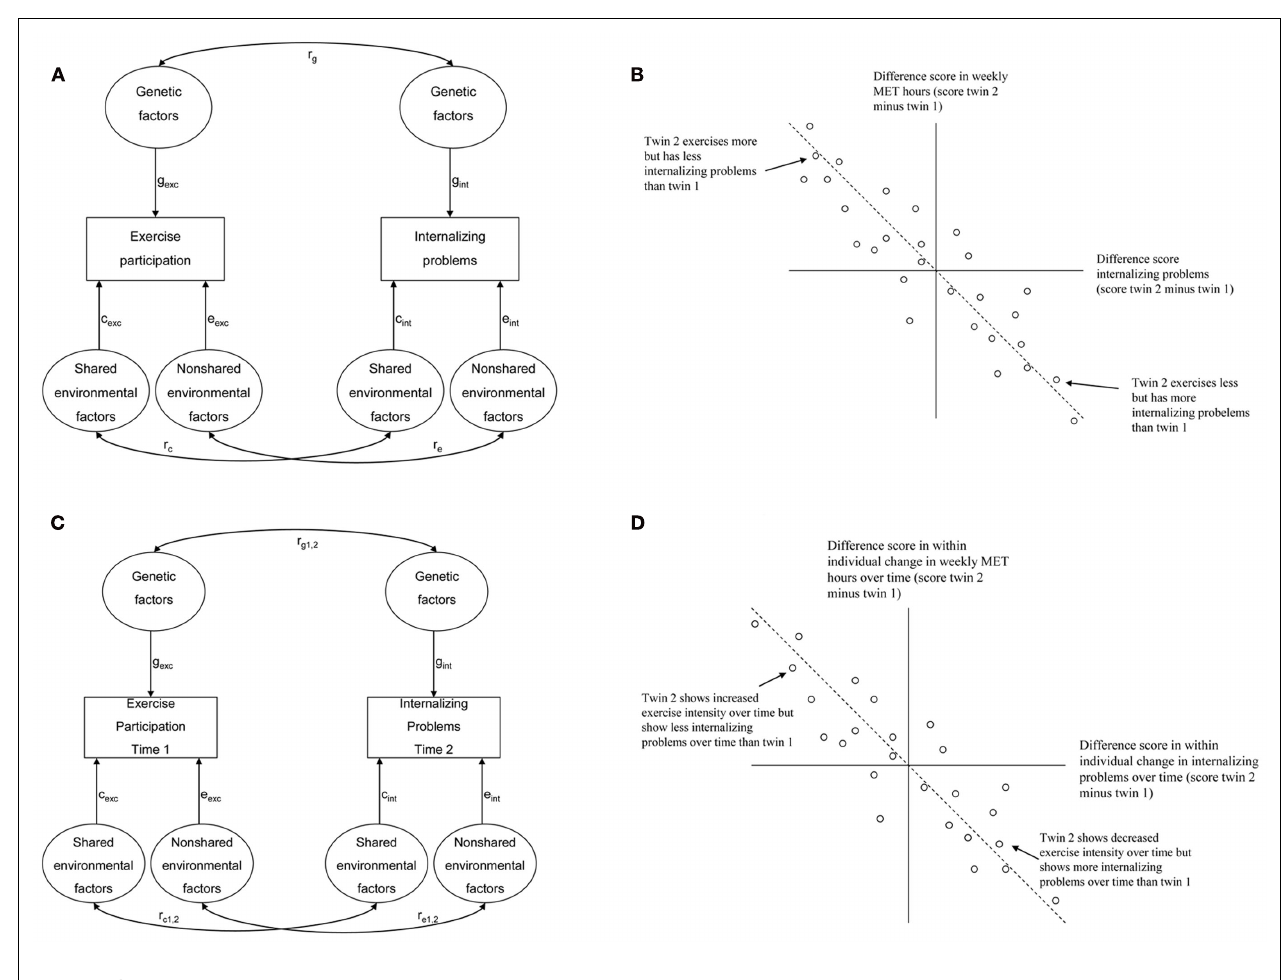
A causal effect of exercise predicts a correlation between genetic, shared environmental, and non-shared environmental factors influencing exercise behavior at time 1 and internalizing problems at time 2. Longitudinal correlation between exercise at time 1 and internalizing problems at time 2 = ( g exc × r g1,2 × g int ) + ( c exc × r c1,2 × c int ) + ( e exc × r e1,2 × e int ). (D) A causal effect of exercise predicts that in genetically identical twins, the twin who increases exercise